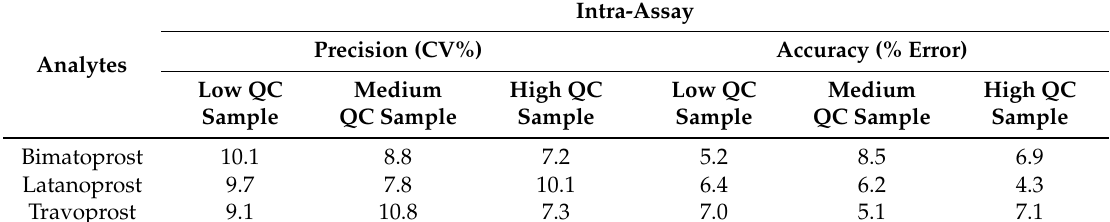
Table 3. Intra- ( n = 5 for each QC sample) and inter-assay ( n = 15) precision and accuracy for prostaglandin analogs (PGAs) in eyelash enhancing cosmetic serums.